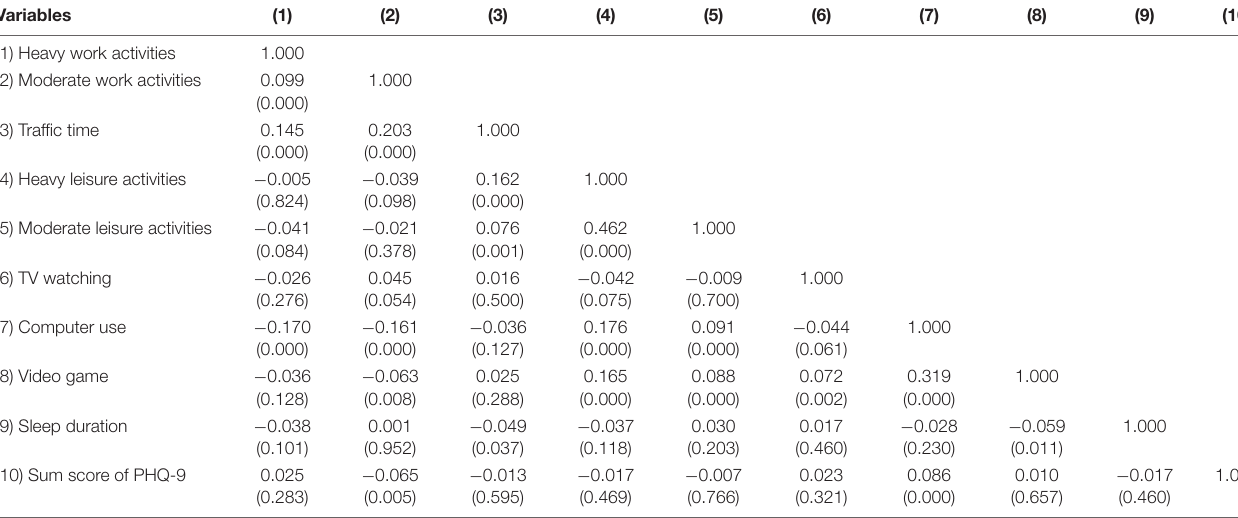
TABLE 2 | Correlation matrix of relationships among time use and the total score of